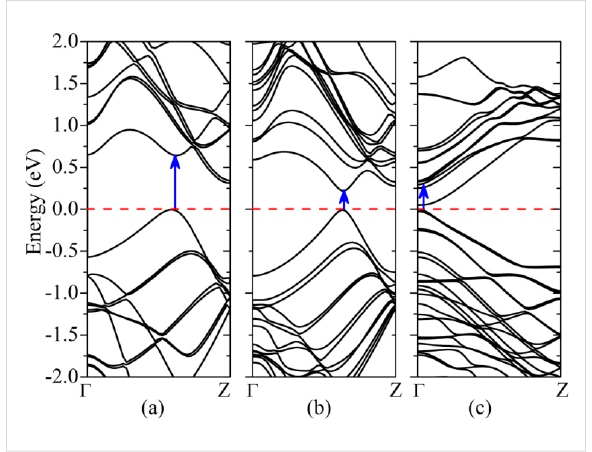
Figure 2: Band structures of silicon nanotubes (4,4) (a), (6,6) (b) and (10,0) (c). The Fermi level is set at the top of valence band, and the arrows indicate the k point where the inter band transitions